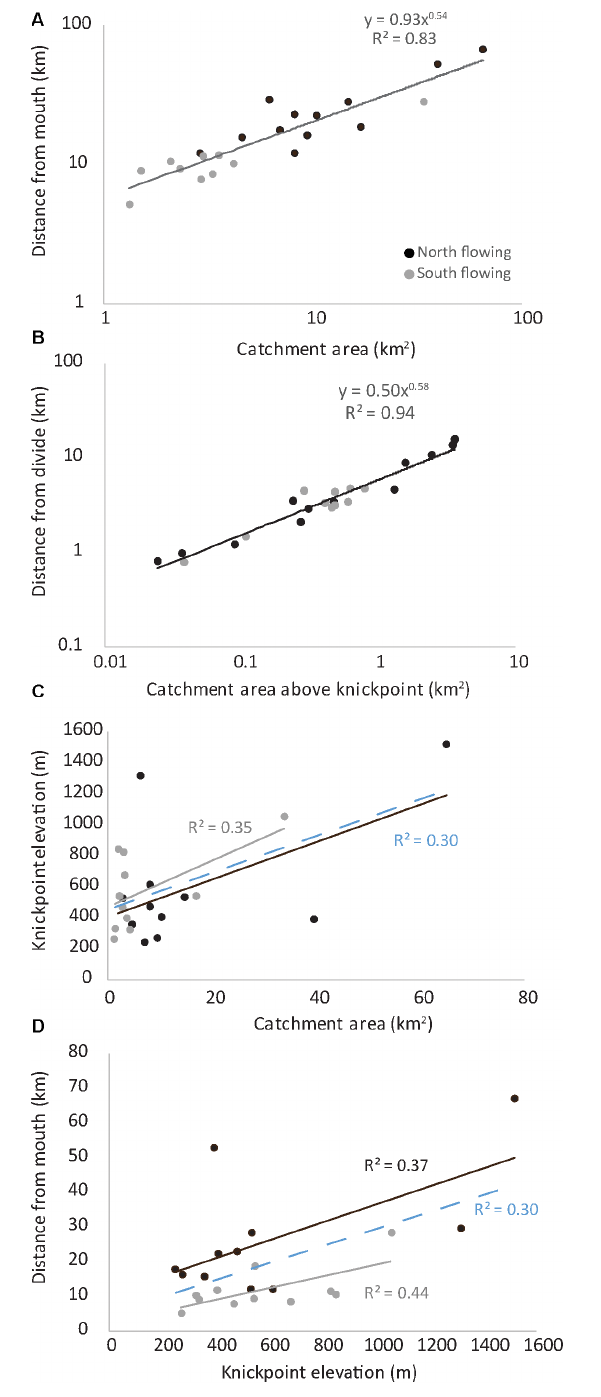
FIGURE 6 | Graphs showing a range of knickpoint variables for Guadalcanal where black circles are knickpoints on north flowing rivers and gray are on south flowing rivers, similarly regression lines are black and gray for north and south rivers, respectively and the blue lines are for all data points. (A) Distance from mouth against total catchment area, (B) Distance from divide against catchment area above the knickpoint, (C) Knickpoint elevation (above sea-level) against total catchment area and (D) distance from mouth against knickpoint